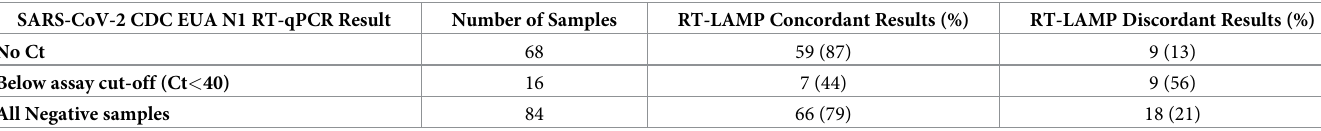
Table 2. Fluorescent RT- LAMP of SARS-CoV-2 negative NP swab samples. SARS-CoV-2 CDC EUA N1 RT-qPCR